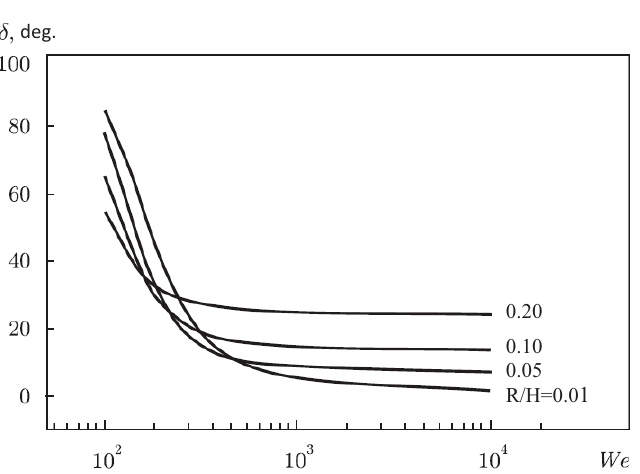
Figure 3. Angle of the wetted part of the edge versus the Weber number for cavitation number σ = 1.0 and various edge